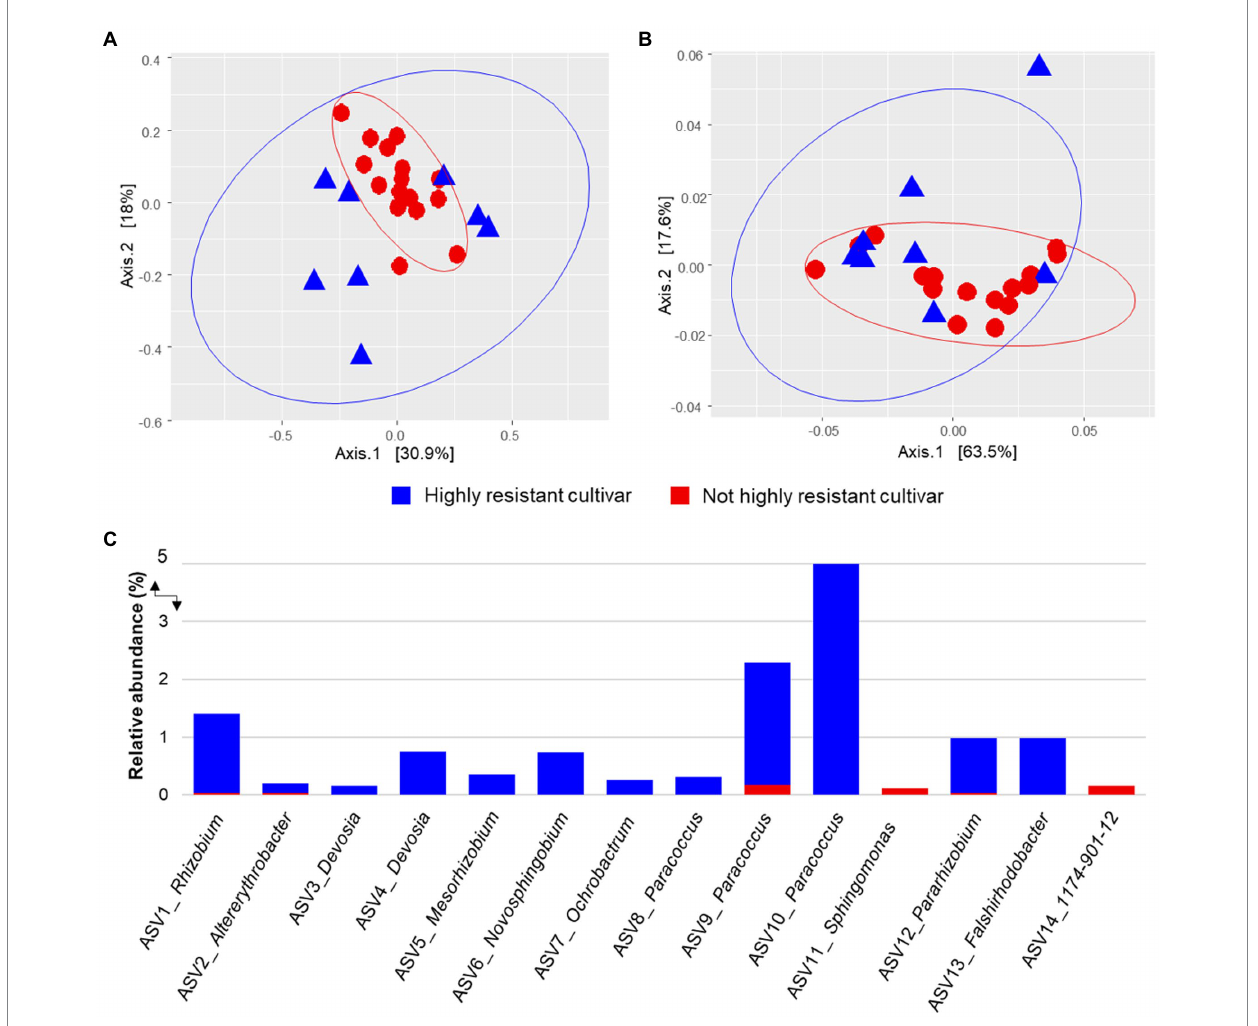
FIGURE 3 Alphaproteobacterial community structure of grapevine cultivars with different resistance (highly resistant, i.e., V. amurensis Rupr and V. riparia L. vs not highly resistant, i.e., Vitis vinifera L. subsp. Sylvestris , Vitis vinifera L. subsp. vinifera “ Blauer Wildbacher,” Vitis × alexanderi Prince ex Jacques “Isabella,” and Vitis vinifera L. subsp. vinifera “Müller Thurgau”) traits against Plasmopara viticola . Alphaproteobacterial community clustering was assessed based on Bray–Curtis (A) and weighted UniFrac (B) matrix distances and visualized PCoA plots. Alphaproteobacterial ASVs that were differentially abundant between highly resistant cultivars (blue bars) and not highly resistant cultivar samples (red bars) according to edgeR analysis (C)